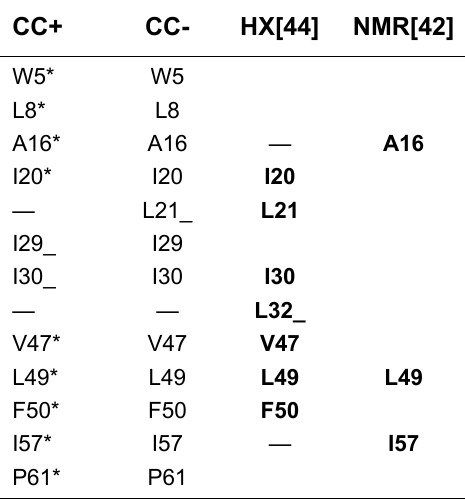
Residues Around the Positive and Negative Charge Centers (CC+, CC-), of the Hydrogen Exchange Core (HX) and of the Folding Nucleus (NMR), CI2 from Barley (PDB 1 ciq) CC+ CC-